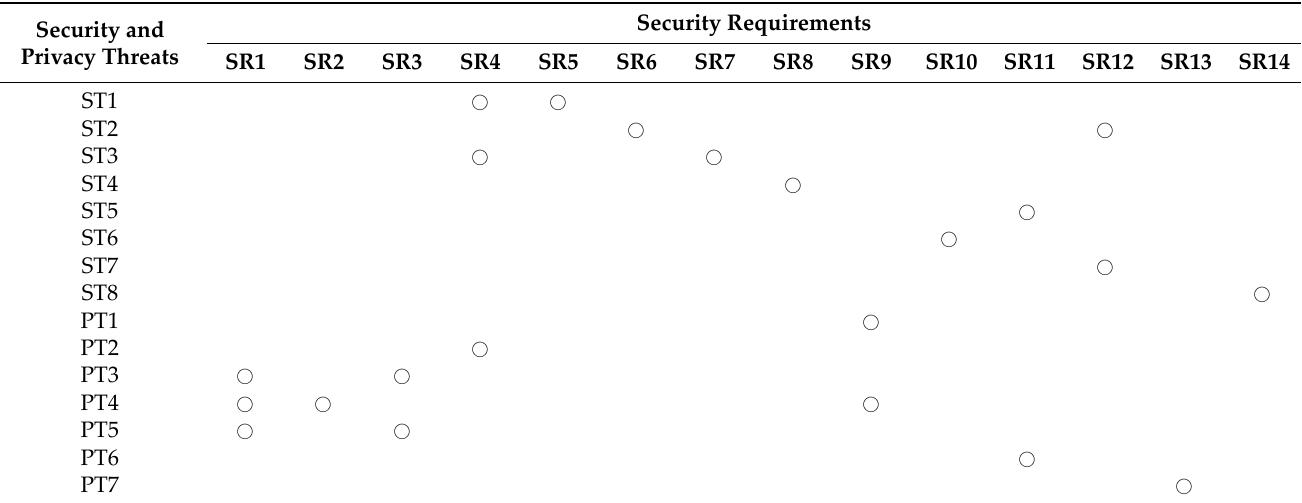
Table 7 shows the 1:1 or 1:N mapping data of the model’s security and privacy threats for the corresponding security requirements. Table 7. Security–privacy threats and security requirements mapping